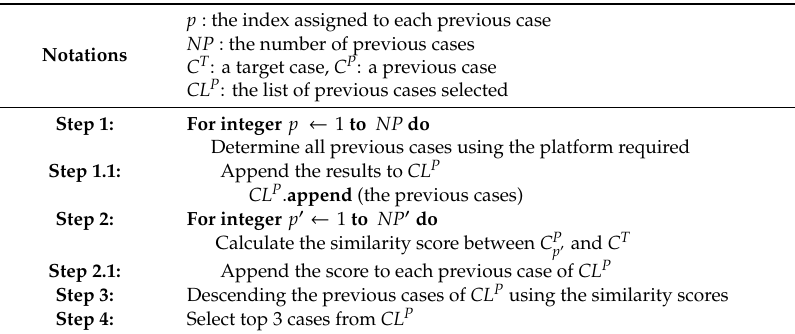
Table 1. Process to retrieve similar